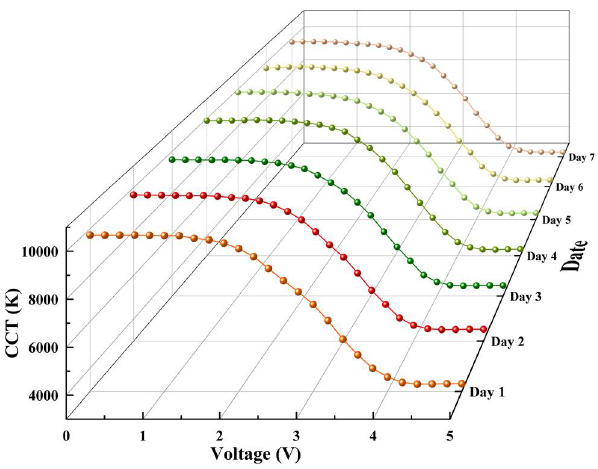
Figure 7. CCT change curves of LEDs VS voltage of ITO glass in one week